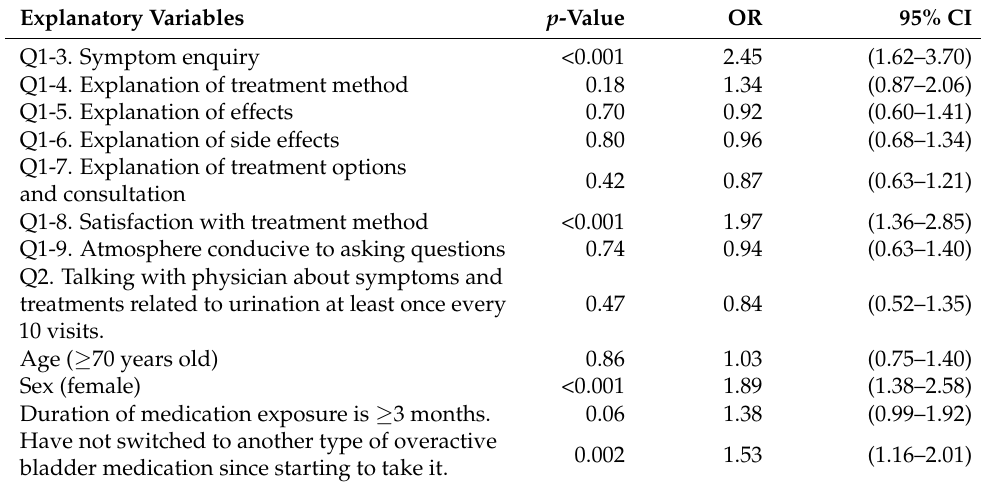
Table 3. Endpoint 2: Association with the effectiveness of overactive bladder medication (presence or absence of improvement ≥ 3 points in